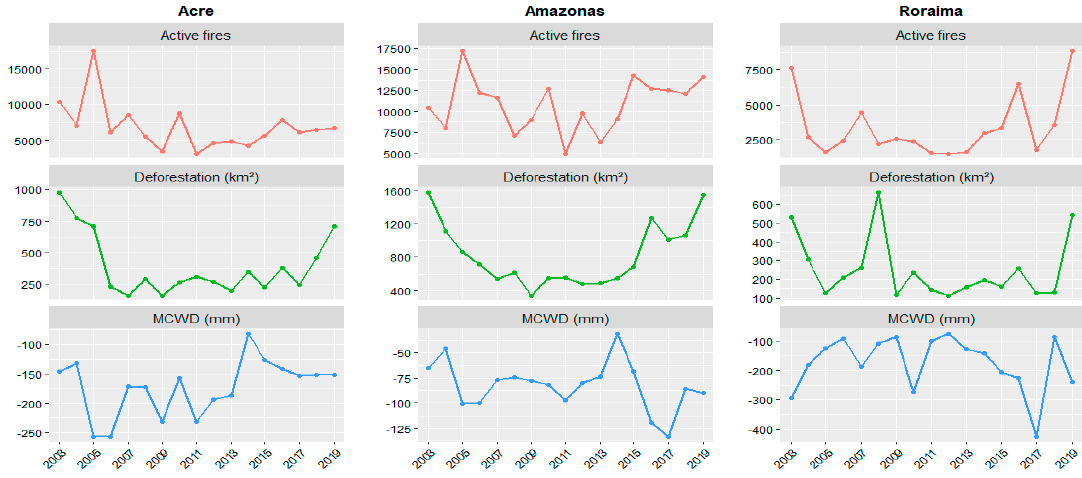
Figure 3. Yearly time-series for total number of active fires in red, old-growth deforestation in green, and mean Maximum Cumulative Water Deficit (MCWD) in blue, for three Amazonian states.